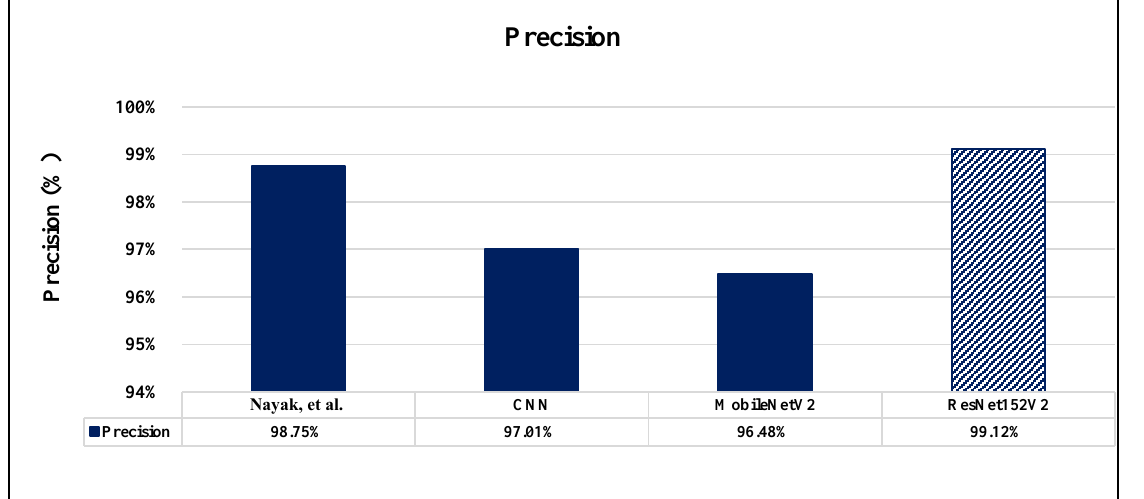
Figure 16. Accuracy performance metrics comparison between our proposed models and previous studies [11,18,20] .